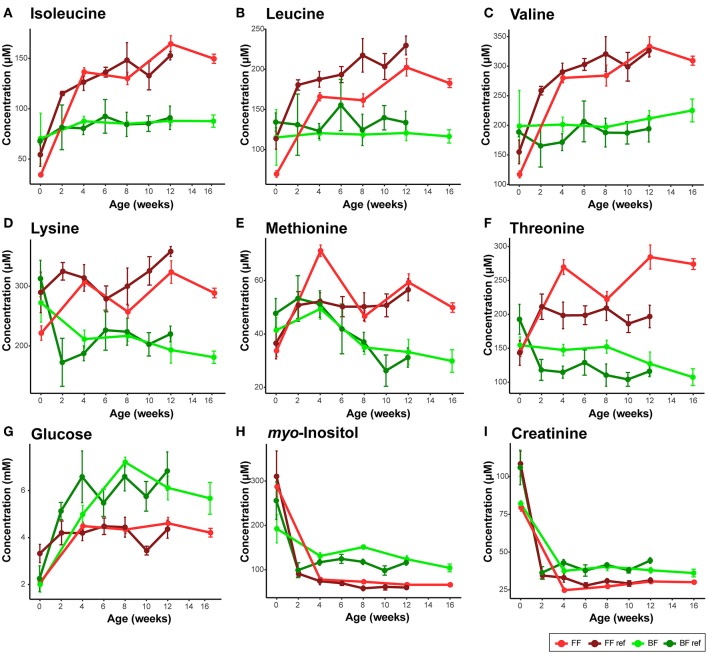
Comparison of serum metabolites that are consistent between the breast-fed (BF) and formula-fed (FF) rhesus infants from the current study and the breast-fed reference (BF ref) and formula-fed reference (FF ref) from previous work (14). Serum metabolites including (A) isoleucine, (B) leucine, (C) valine, (D) lysine, (E) methionine, (F) threonine, (G) glucose, (H)
myo-inositol, (I) creatinine were measured from birth to 16 weeks of age in the current study. Data are presented as mean ± SEM.